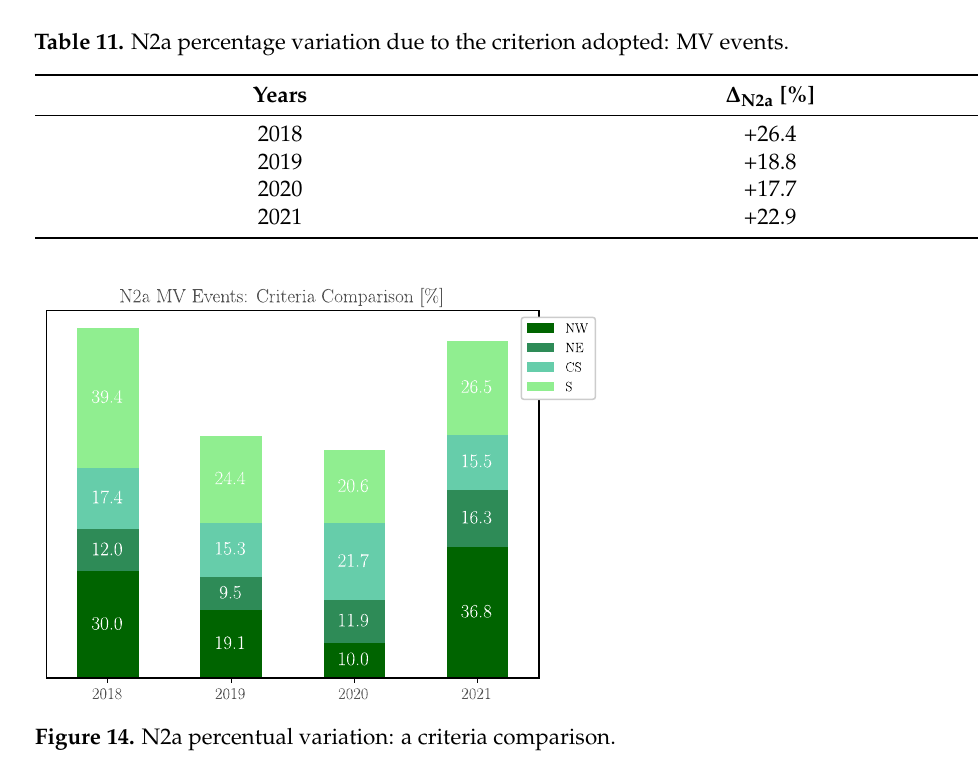
Table 12. N3b comparison: overall events.